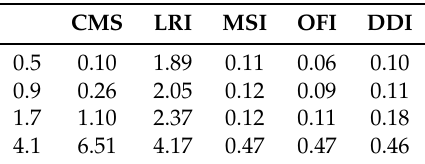
Table A2. Accel.XS in short